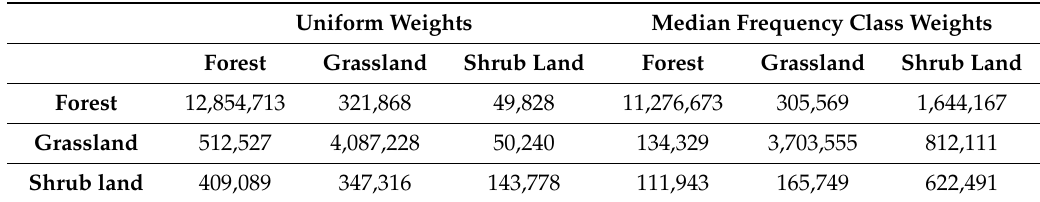
Table 8. Confusion matrices for uniform and median frequency class weights (Slovenia—3 classes).